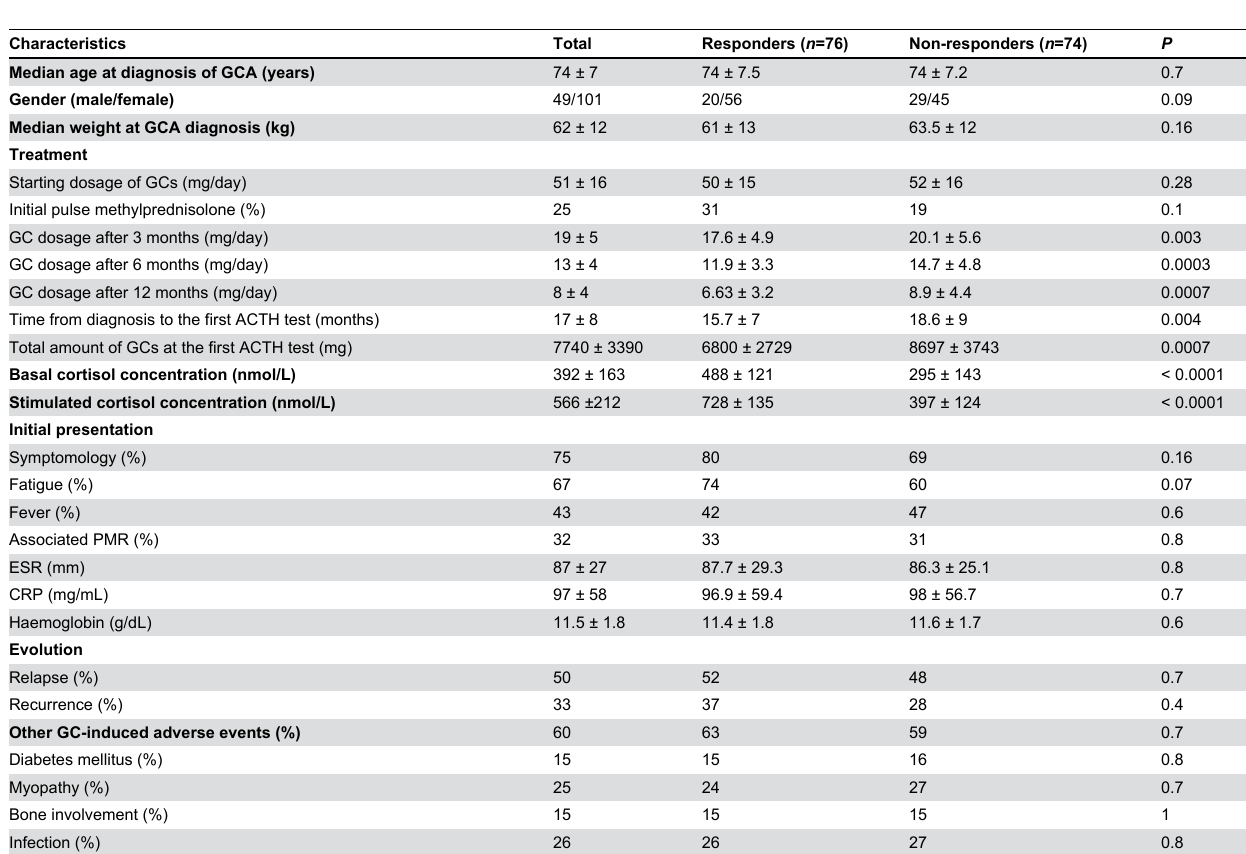
Table 1. Baseline characteristics, outcomes and comparisons between responders and non-responders to the first ACTH stimulation test during glucocorticoid (GC) treatment for giant cell arteritis (GCA).